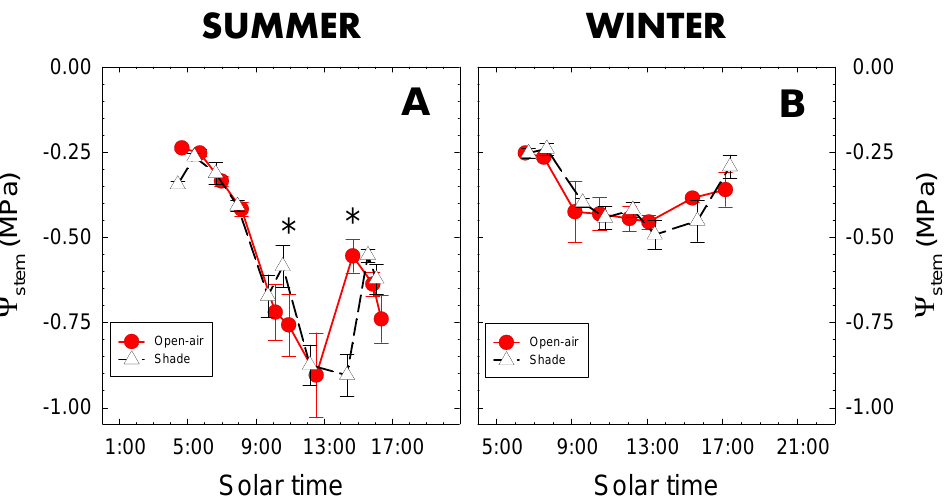
Figure 3. Diurnal course of stem water potential ( Ψ stem ) on representative days of summer (9 August 2018; A ) and winter (13 February 2019; B ) in lime trees grown in open-air (closed symbols) and shaded (open symbols) conditions. Each point is the average of four replications. Vertical bars represent ± standard error (SE). Asterisks indicate statistically significant differences between cropping conditions at p ≤ 0.05.